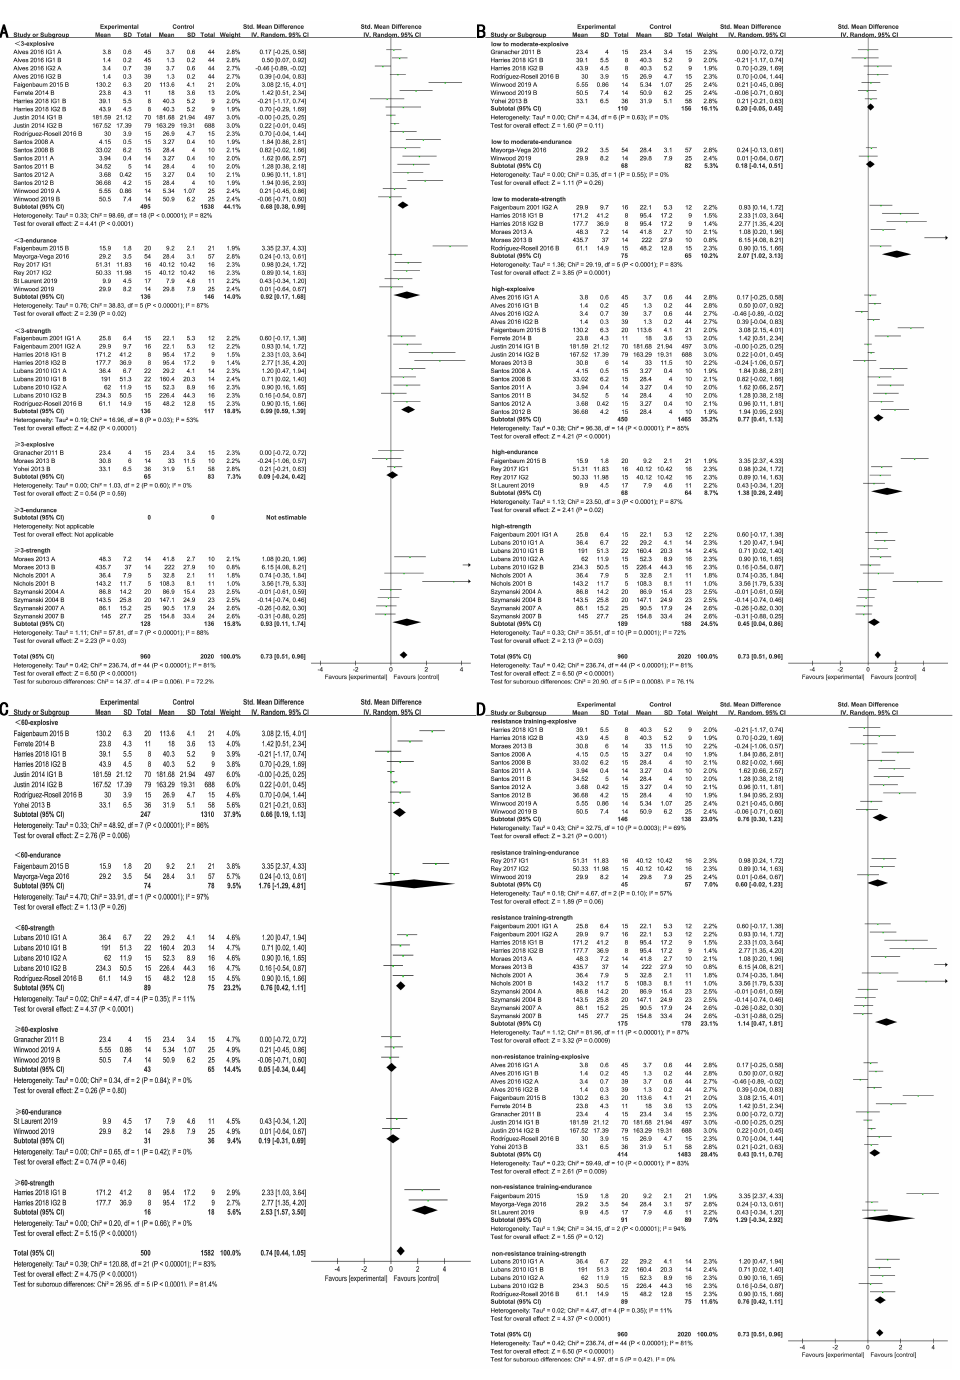
Figure 4. Effects of physical activity elements on muscle fitness. ( A ): Effects of training frequency on muscle fitness; ( B ): Effects of training intensity on muscle fitness; ( C ): Effects of training time on muscle fitness; ( D ): Effects of training type on muscle fitness; A: upper limb; B: lower